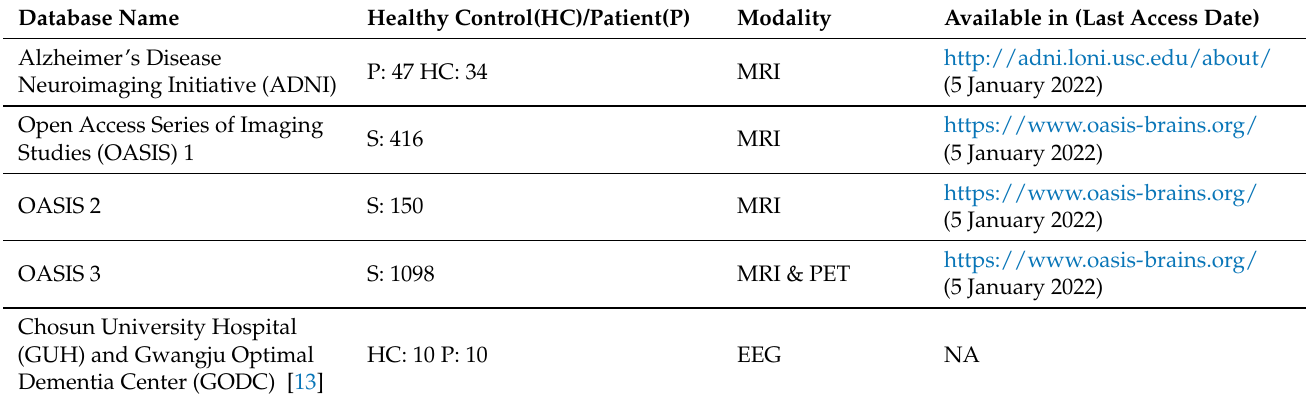
Table 2. A tabulation of popular datasets of Alzheimer’s